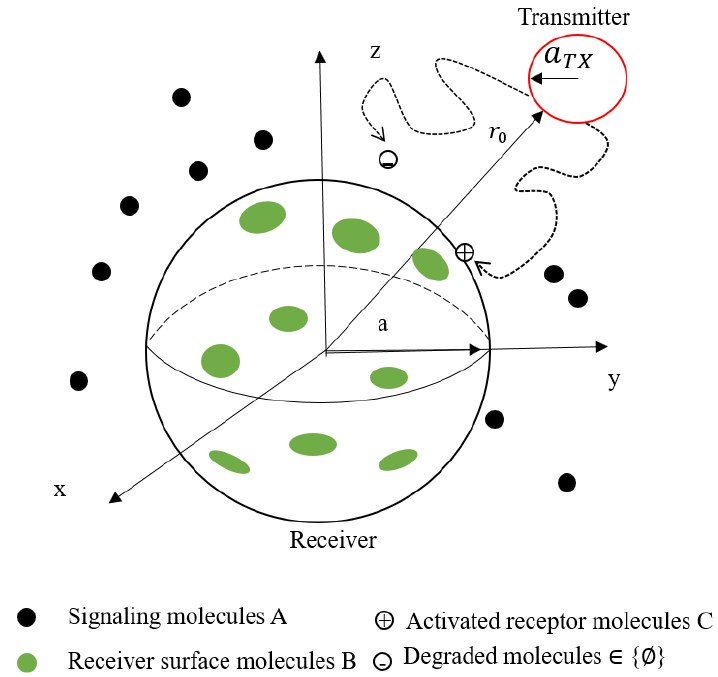
Figure 5. System model considering the volume of transmitter